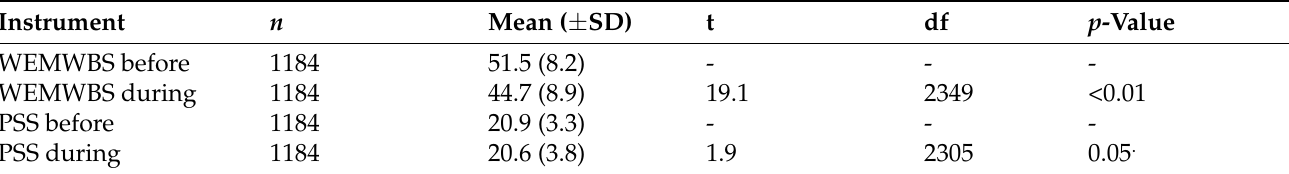
Table 2. Differences in mean scores (before vs. during the COVID-19 pandemic) for the WEMWBS and PSS tests.